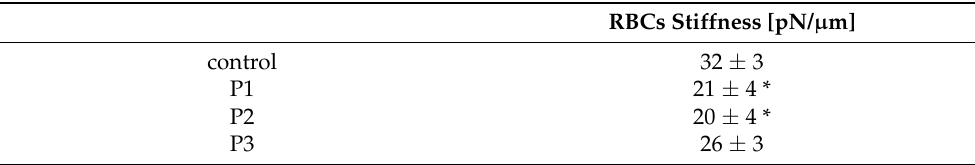
Table 3. Average values ± SD of erythrocyte cell stiffness modified with P1, P2, and P3 liposomal formulation. * Statistically significant differences between control and P1, P2, or P3-treated cells are denoted ( α = 0.05).